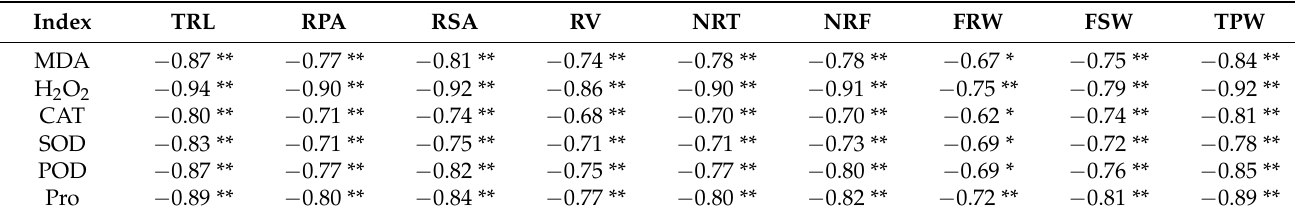
Table 2. Correlation matrix describing the relationship between root morphological characteristics, fresh biomass and